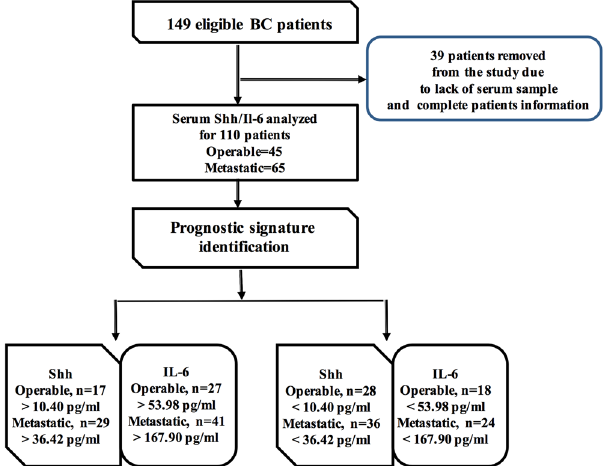
Figure 1. Flow diagram of patients selection and study design. One hundred ten patients were included in the study with serum samples and complete patient’s data, while thirty-nine patients were excluded from the study due to the lack of serum sample and patient’s complete